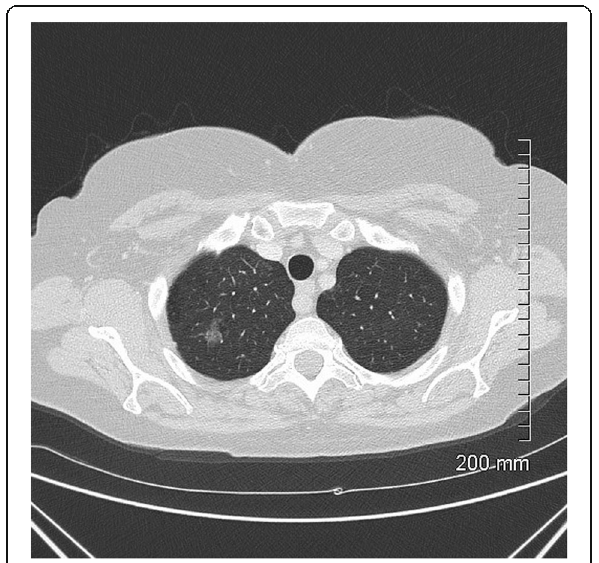
Fig. 13 Favourable prognostic indicators: bubble-like lucencies in a part-solid right lower lobe nodule. MIA